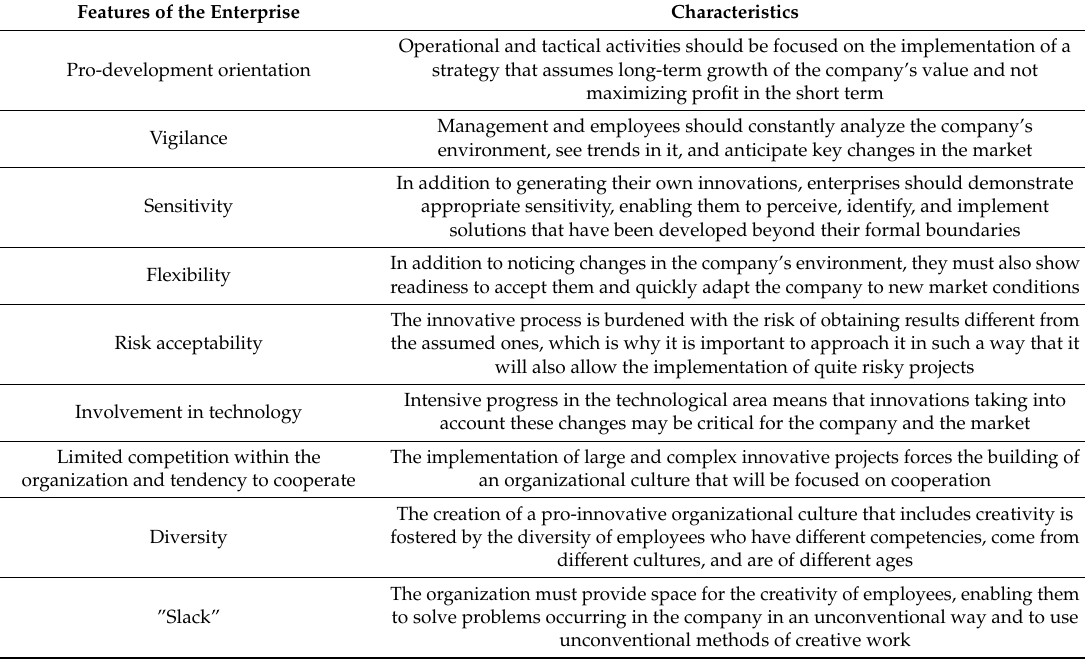
Table 1. Features of an organization that is focused on the implementation of innovative